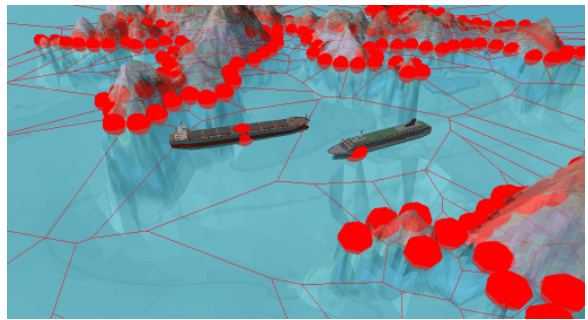
Figure 1. The incorporated kinetic VD for maintenance of spatial relationships and collision detection